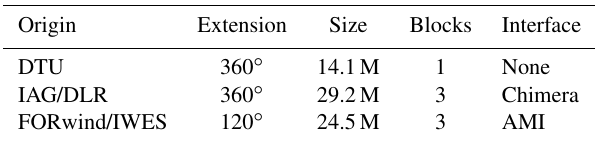
Table 2. Meshes prepared for RANS CFD models on the DAN- AERO NM80 blade (IEA Task 29). Origin Size Blocks 360 ◦ Chimera FORwind/IWES 120 ◦ 24.5M